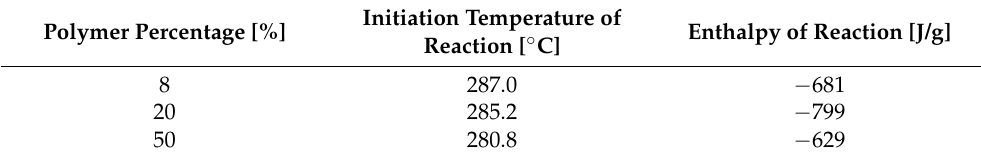
Table 5. Results of DSC analysis of AN and PA mixture with different